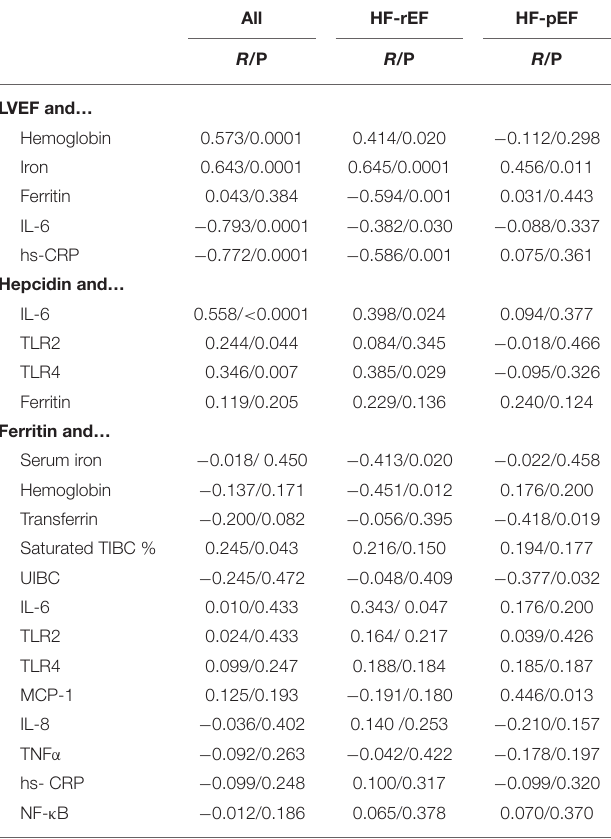
TABLE 4 | Correlational analyses between different parameters in the whole study population and in the two groups separately. All HF-rEF HF-pEF R /P R